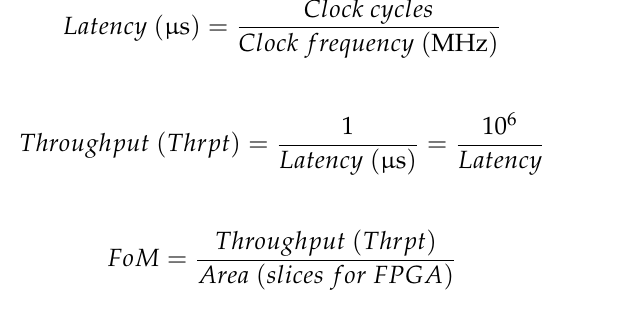
Table 2. Implementation results on Xilinx (Virtex 7) FPGA.